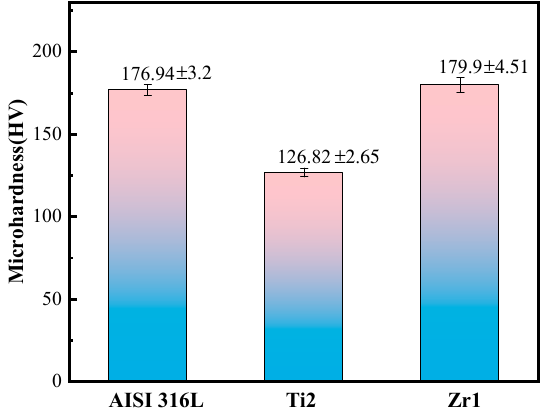
Figure 11. Micro-hardness patterns of AISI 316L, Ti2, and